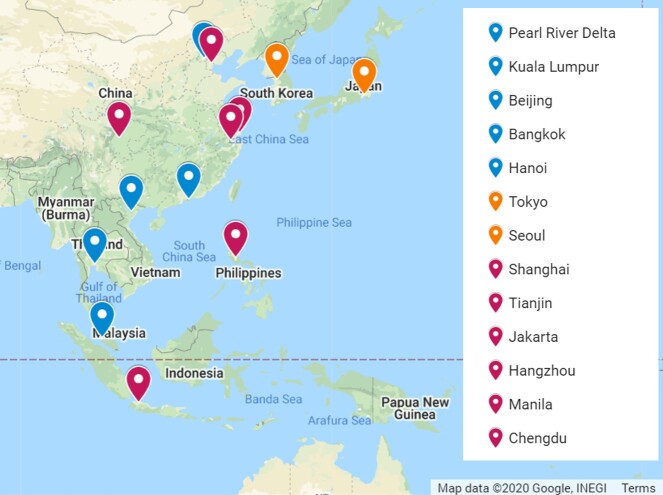
Megacities in East-Southeast Asia featured in Figure 1 of Schneider et al. (2015). Butterfly sampling has been completed in urban parks by the "Urban Butterflies in Asia Research Network" (Sing et al. 2017, Sing et al. 2016a, Sing et al. 2016b, Sing et al. 2019, Wilson and Sing 2020) at those megacities with blue markers. Butterfly sampling has been completed in urban parks by other researchers (Matsumoto 2015, Nagase et al. 2019, Lee et al. 2015) at those megacities with orange markers. To our knowledge, no butterfly sampling has been published for urban parks at those megacities with magenta markers.